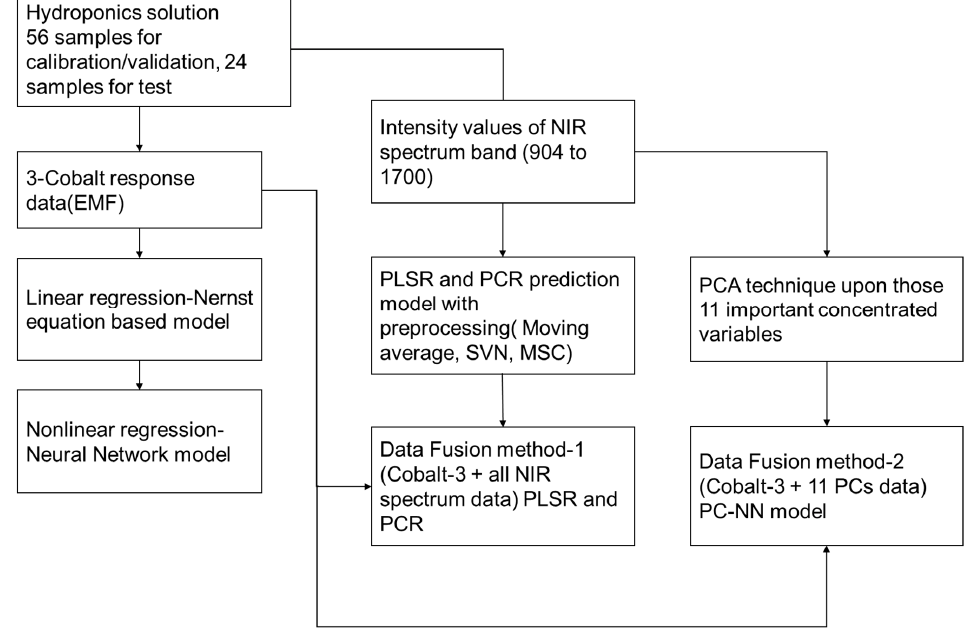
Figure 3. Block diagram of the proposed algorithms.